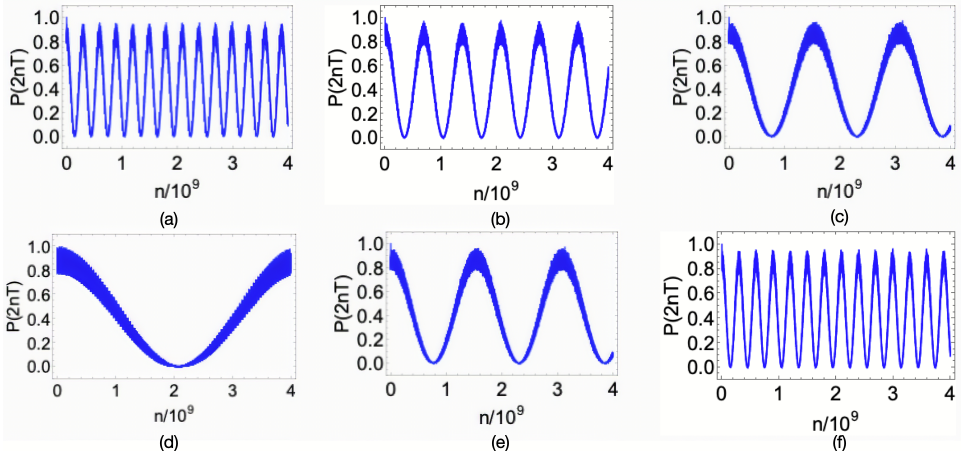
Figure 4. ( a – f ): The stroboscopic return probability at times 2 nT ( P ( 2 nT )) for a 11-site spin chain = 0.75, 0.85, 0.95, 1, 1.05, and 1.25 respectively, and (cid:101) = 0.1 π . with nearest-neighbor interactions; JT π We find that time crystal signatures can be observed for a wide range of JT , and the time crystal lifetime is maximum when JT = π